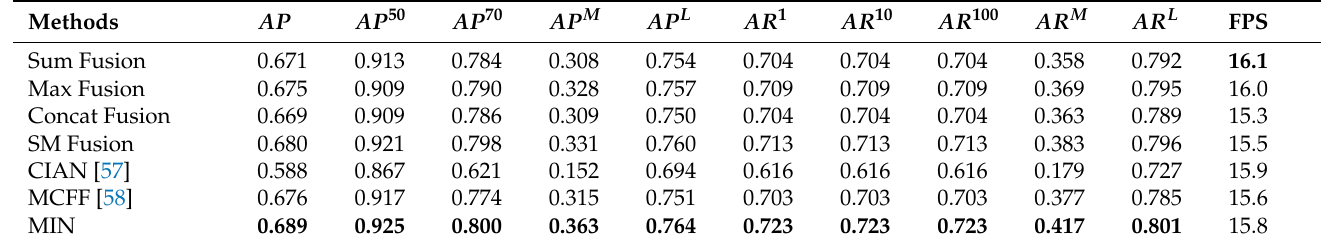
Table 4. Feature fusions of different methods are compared.